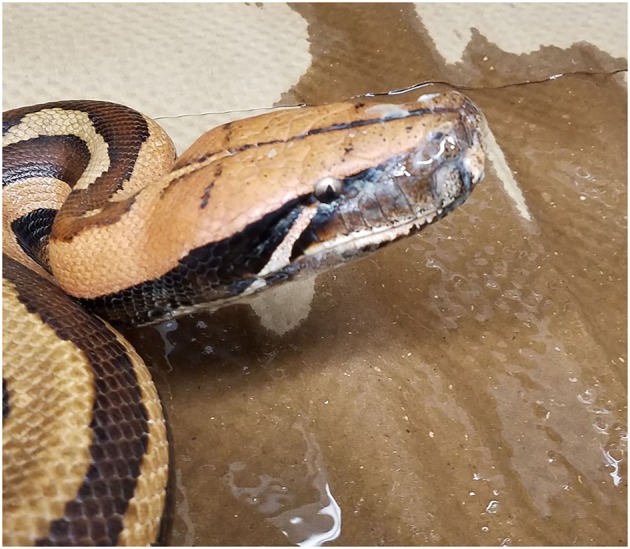
Excessive oral and nasal mucus production in a serpentovirus-positive snake. Blood python; Collection H.